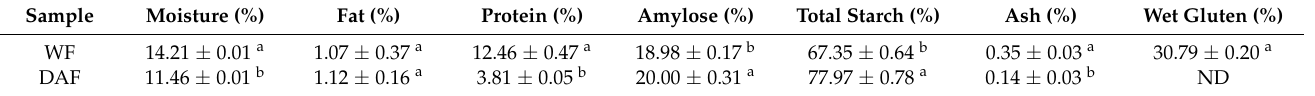
Table 1. Basic physical and chemical composition of acorn and wheat flour a,b,c .